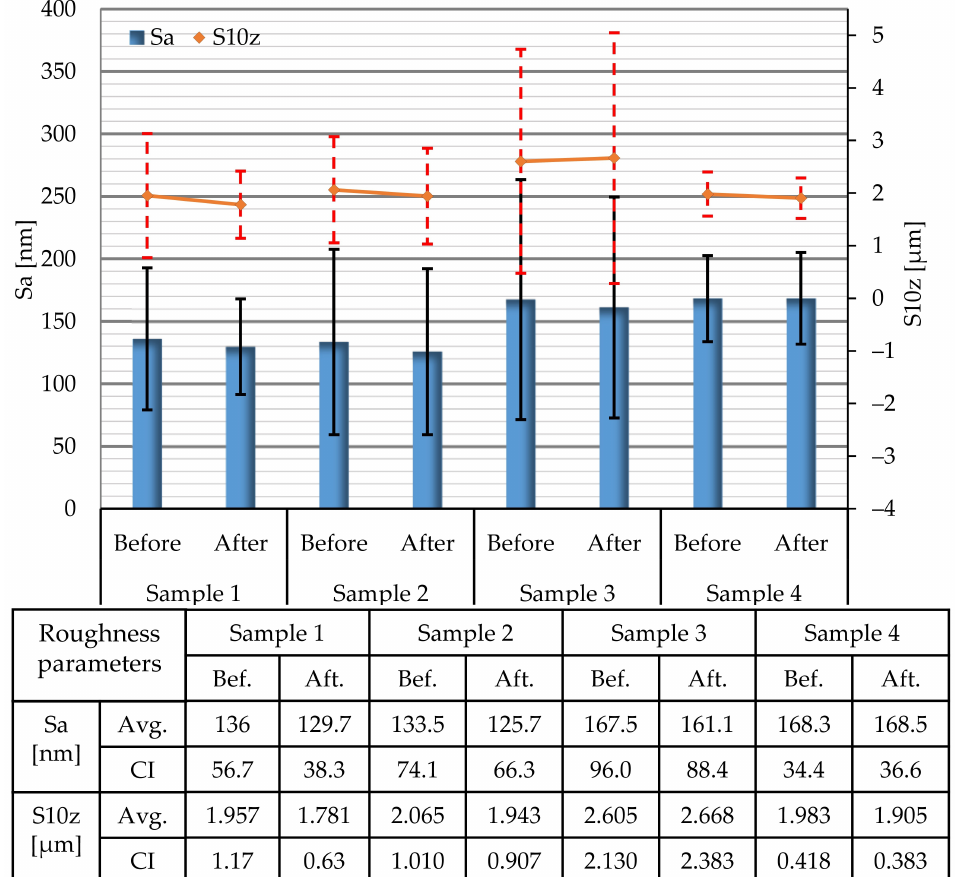
Average values (Avg.) of Sa and S10z surface roughness parameters determined on areas of Figure 2Figure 2. 80 × 80 µ m and corresponding confidence intervals